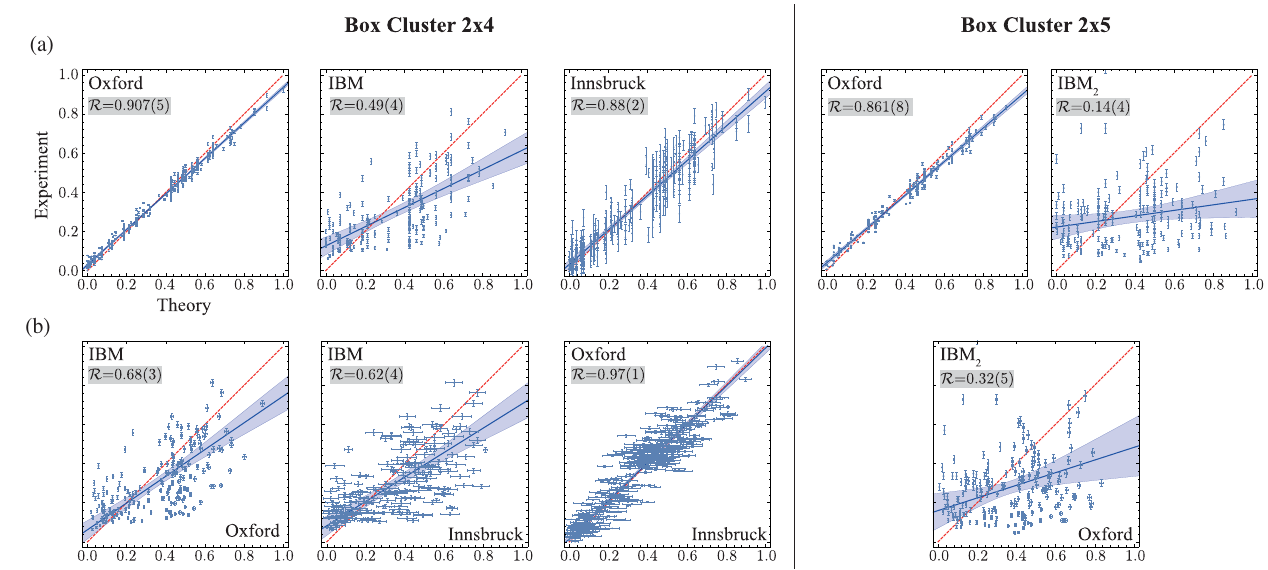
FIG. 11. Data for cross-verification using the box clusters 2 × 4 (left) and 2 × 5 (right). (a) Scatter plots of outcome probabilities compared to the theoretical expectation for the following (from left to right): Oxford, Innsbruck, IBM for the 2 × 4 -cluster, and Oxford, IBM 2 for the 2 × 5 cluster. The squared l 2 distances k p 1 − p 2 k 2 for these theory comparisons are 0.00200(3), 0.0578(5), 0.0123(6), 0.00400(8), 0.145(1). This is in good agreement with the trends seen from a linear least-squares regression (blue line) quantifying the deviation from the ideal correlation (red dashed line), with the resulting regression slopes R with 1 σ uncertainties given in the top-left corner of the respective figure panel. (b) Scatter plots of the outcome probabilities for 2 × 2 cross-check verification between Oxford- IBM, Innsbruck-IBM, and Innsbruck-Oxford for the 2 × 4 cluster, and Oxford-IBM 2 for the 2 × 5 cluster. The squared l 2 distances k p 1 − p 2 k 2 for the cross-validations are 0.0504(6), 0.060(2), 0.0115(6), 0.118(1). This is in good agreement with the regression coefficients R obtained from linear, total, least-squares regression (blue line) given in the top-left corner of the respective figure panel. Experimental error bars correspond to 1 σ statistical uncertainty, and the blue shaded bands represent 3 σ mean prediction intervals for the